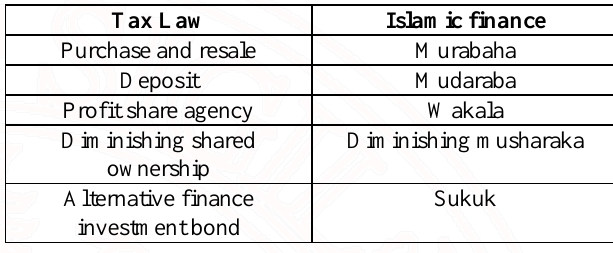
TABLE I. S IMILARITIES BETWEEN THE E NGLISH TAX LAW AND THE VARIOUS I SLAMIC FINANCIAL INSTRUMENTS